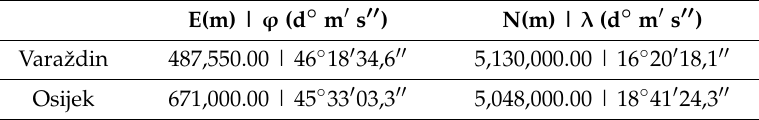
Table 1. The study area coordinates (projection: EPSG 3765 |